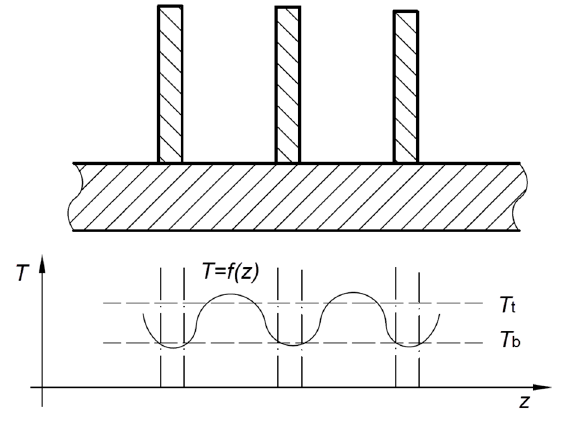
Figure 2. The periodic temperature profile in the tube wall.